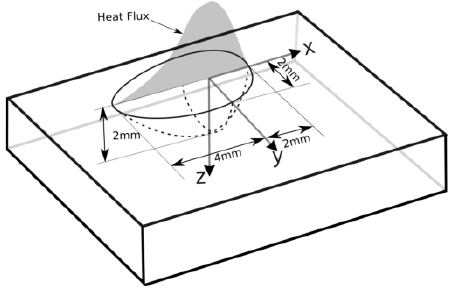
Figure 8. Gaussian distribution of density and double ellipsoid shape in xy